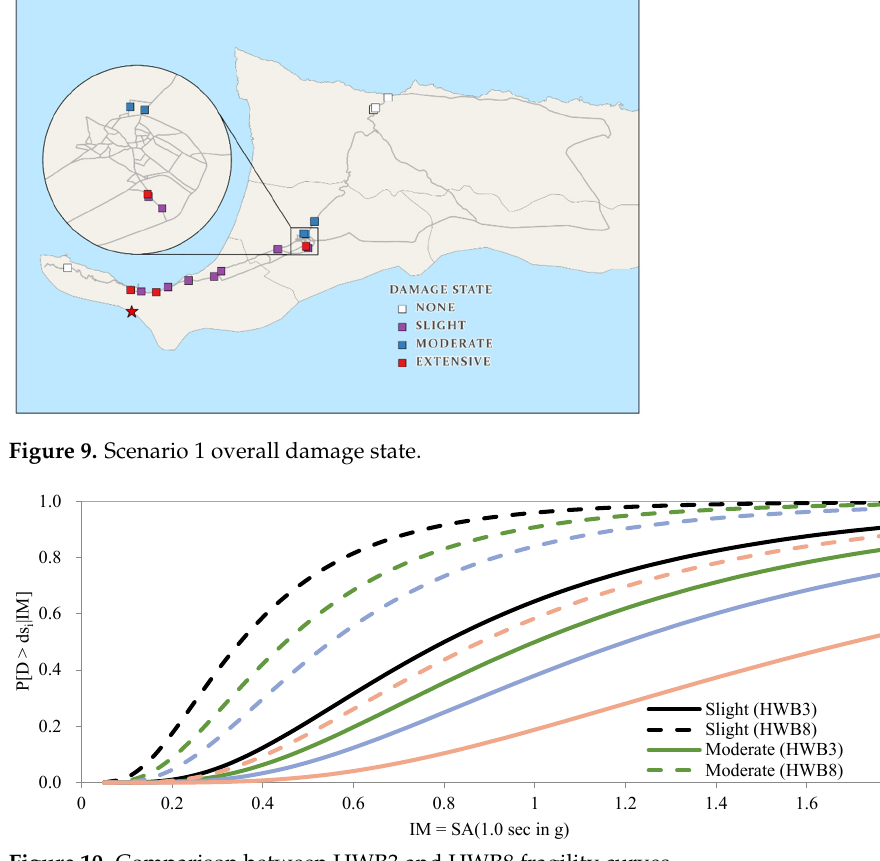
Figure 10. Comparison between HWB3 and HWB8 fragility curves.